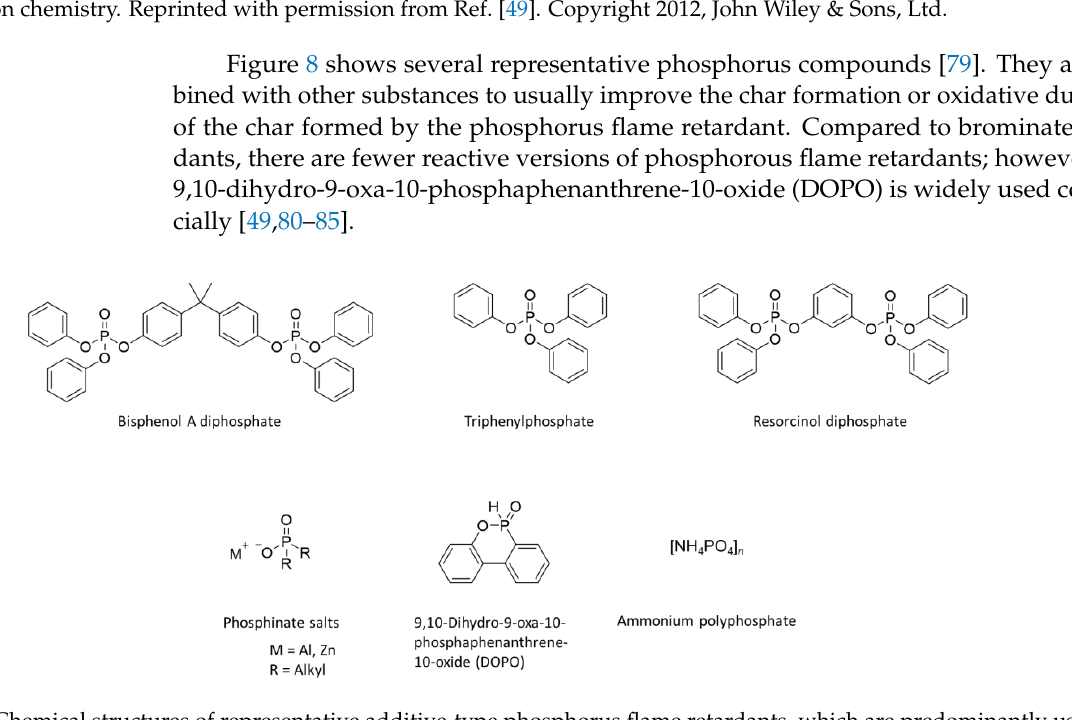
Figure 8. Chemical structures of representative additive-type phosphorus flame retardants, which are predominantly used in the vapor phase, and not in the condensed phase. Reprinted with permission from Ref. [79]. Copyright 2015, Springer.